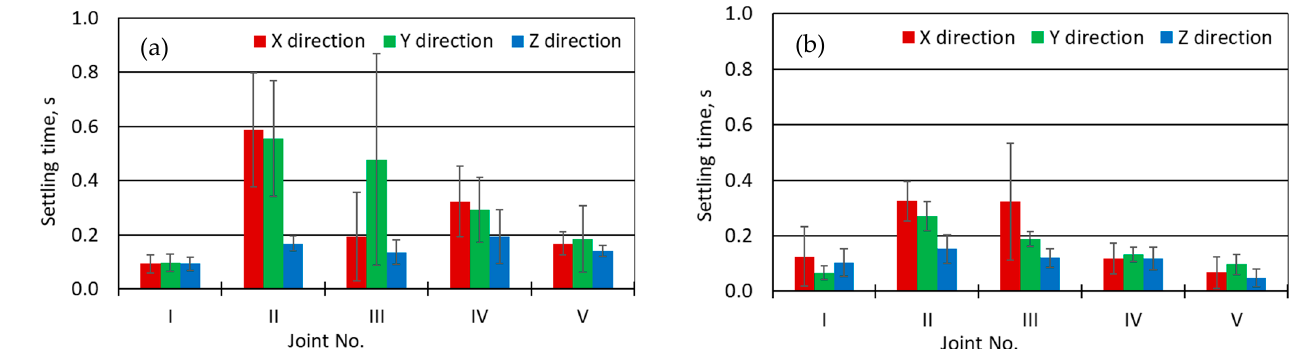
Figure 13. Settling time evaluated after rotation of separate joints in: ( a ) clockwise direction; ( b ) counterclockwise direction. Statistical evaluation was performed by Equations (8)–(13). Robots start position is shown in Figure 3a.